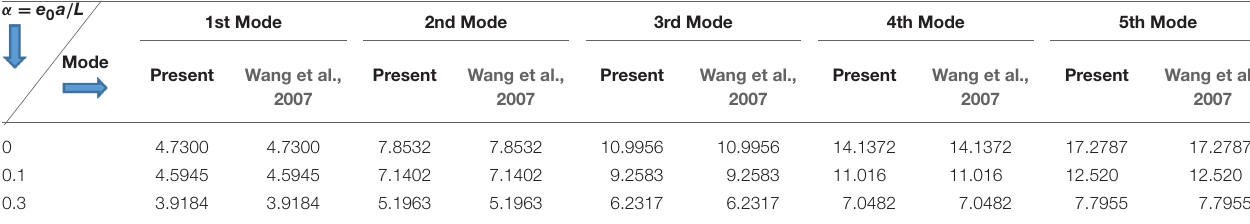
√ λ for CC case. (cid:16) (cid:17)